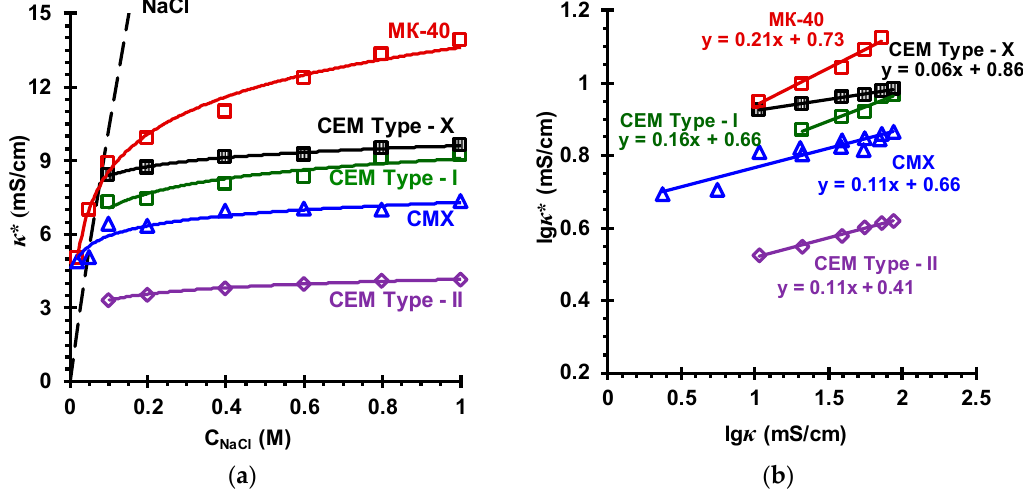
Figure 7. Concentration dependences of the conductivity of different cation-exchange membranes, κ *, in NaCl solutions ( a ) and the lg κ * vs. lg κ dependences of these membranes in NaCl solutions ( b ). The names of the membranes are indicated near the curves, which fit the experimental data. The dashed line in the figure ( a ) is the concentration dependence of the NaCl solution conductivity.